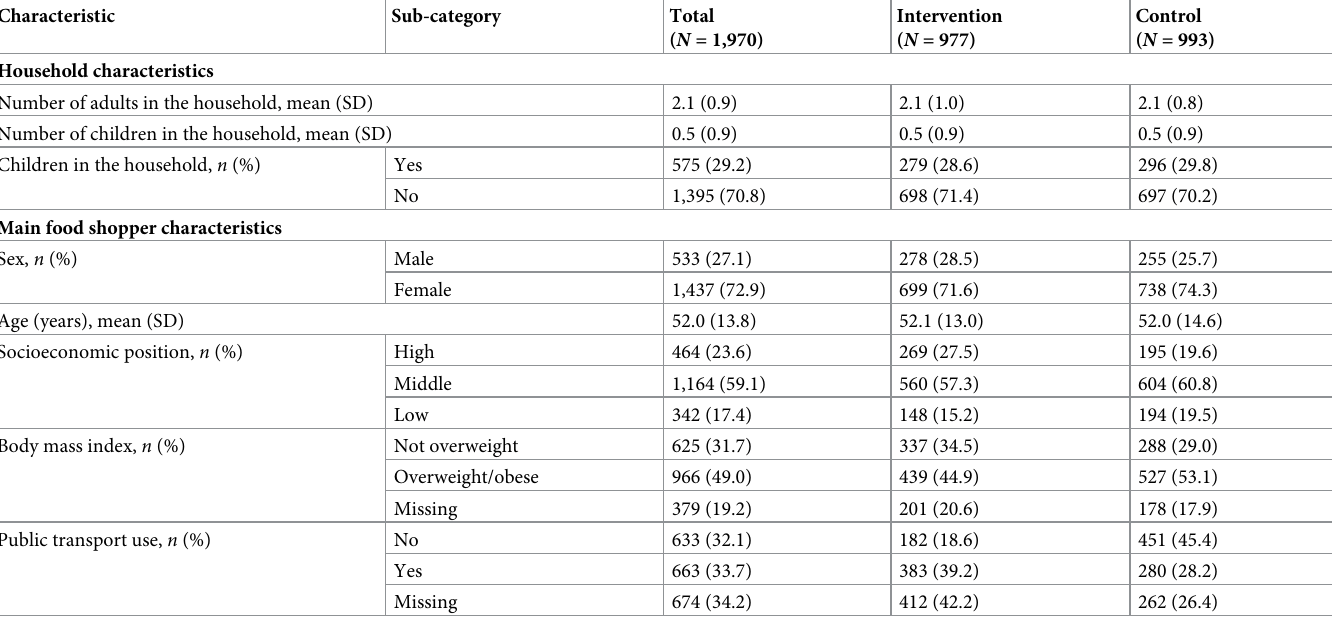
Table 1. Descriptive characteristics of the overall, intervention, and control